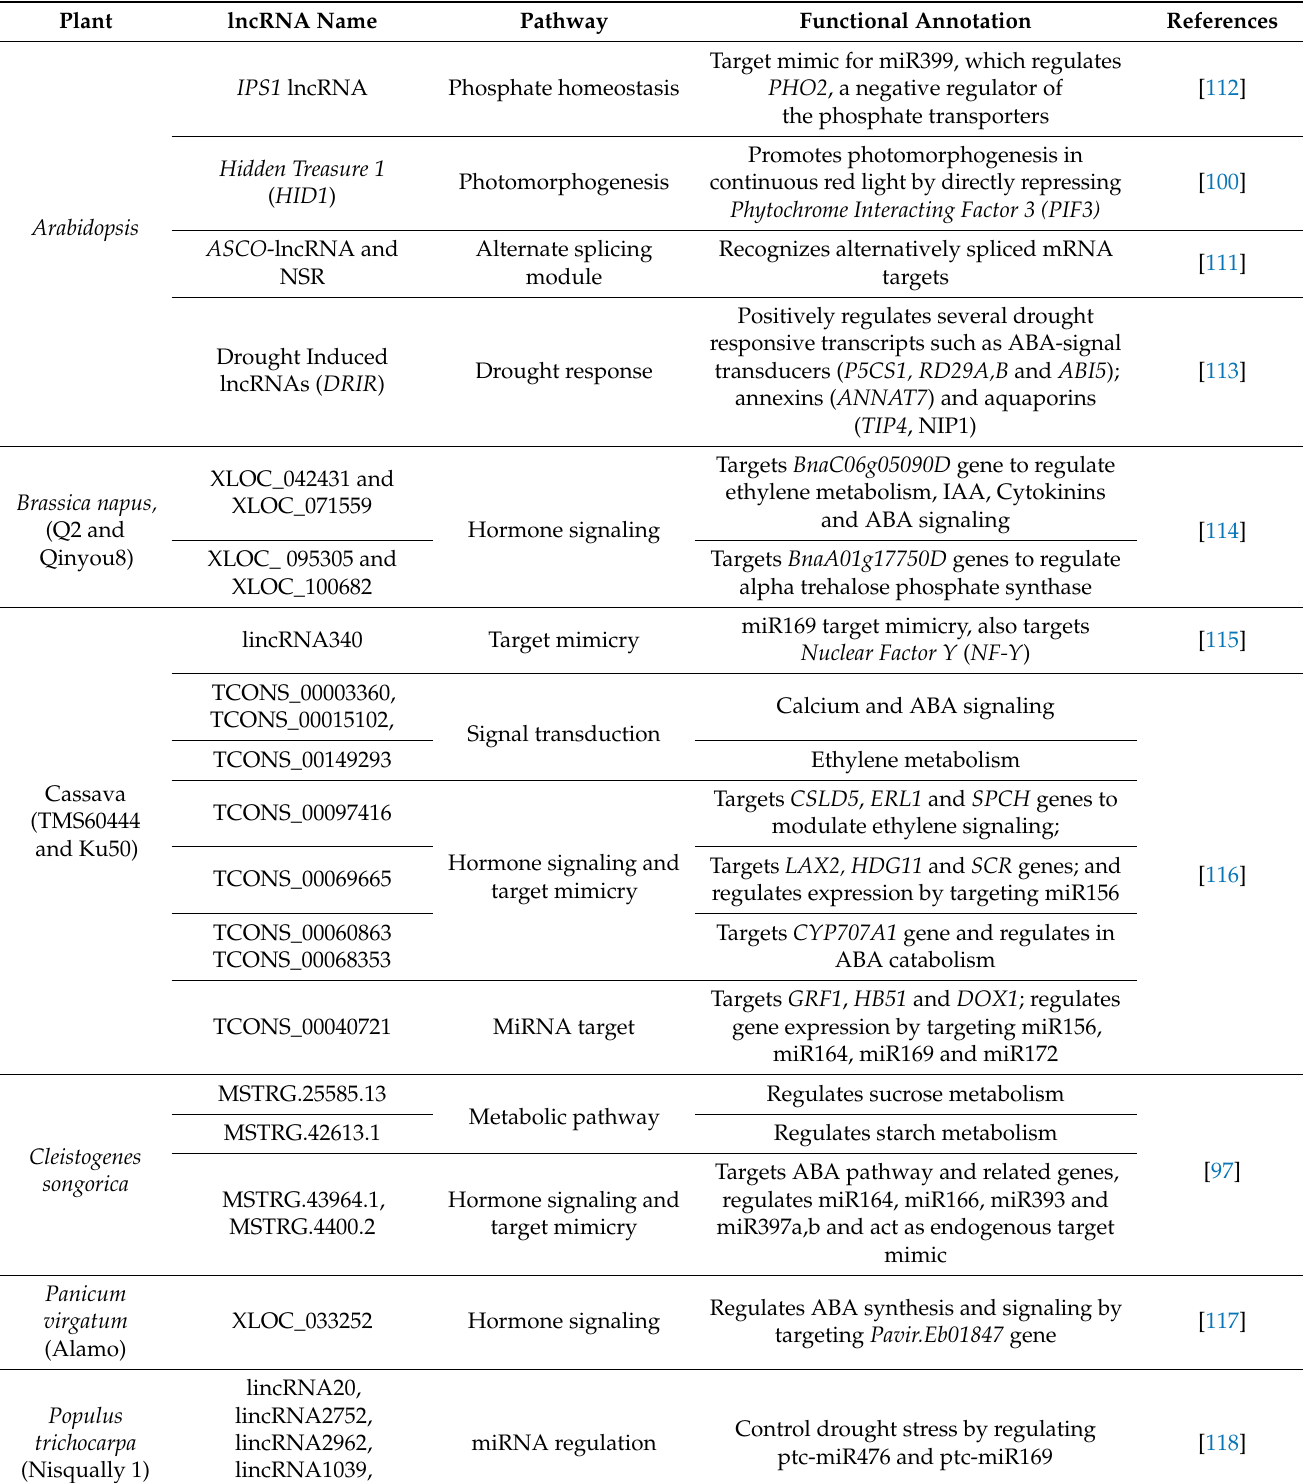
Table 1. Functions of lncRNAs identified in various